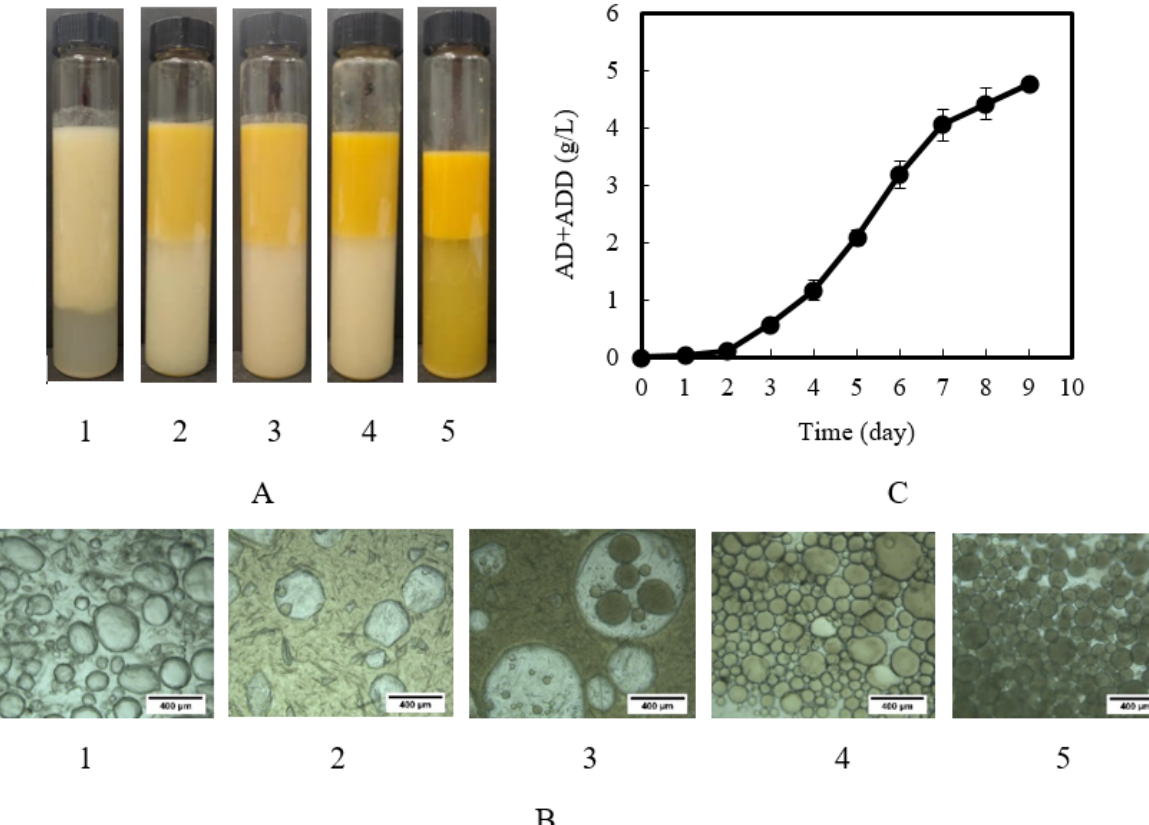
Figure 5. Time course of microbial transformation with high loading of crystal phytosterols: ( A ) Emulsion fraction. ( B ) Microscopic emulsions (bar = 400 μ m). ( C ) AD and ADD concentrations. In the basic experimental condition, the volume ratio of soybean oil to the aqueous culture medium was 15:35 mL. The glucose concentration in the aqueous culture medium was 10 g/L. The concentration of phytosterols in the soybean oil was 80 g/L. No. 1, 2, 3, 4, and 5 corresponded to microbial transformation times of 1, 3, 4, 5, and 9 days, respectively.